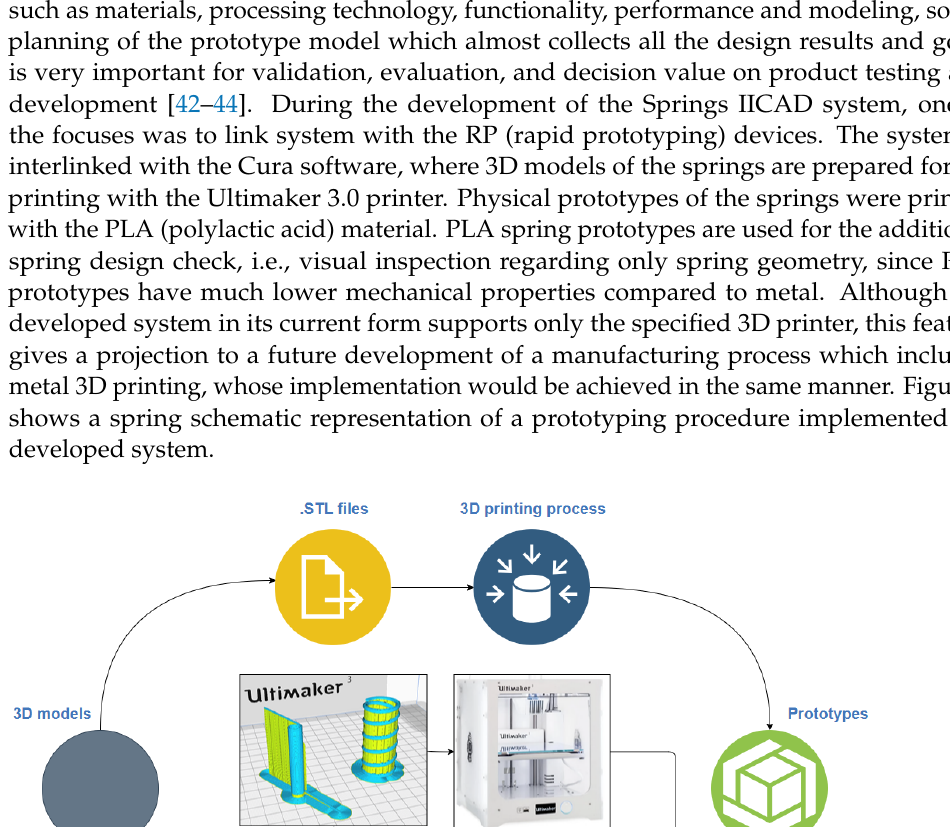
Figure 10. C# code for the “documentWriter” function. 4. Conclusions The implementation of the intelligent approach into a design process helps designers and engineers to solve various problems faster and more efficiently. The developed Springs IICAD system links the spring design modules directly with the parametric 3D models, FEM analysis, prototype preparation and rapid prototyping. Unlike the tradi-